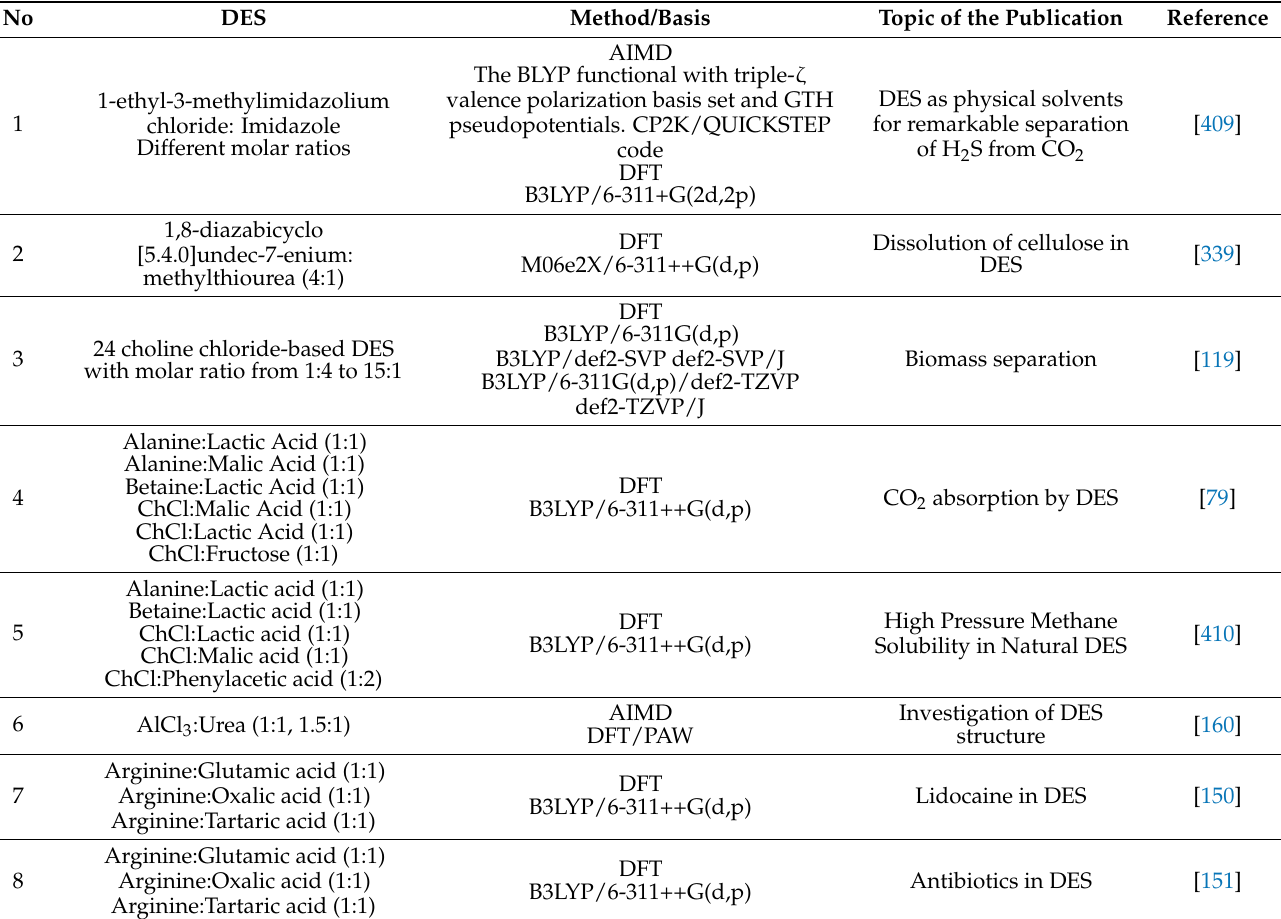
Table A2. QM calculations of DES consisting systems, method and basis, and the topic of the publication. Corrections of method and basis are not indicated. We refer to current publications for the